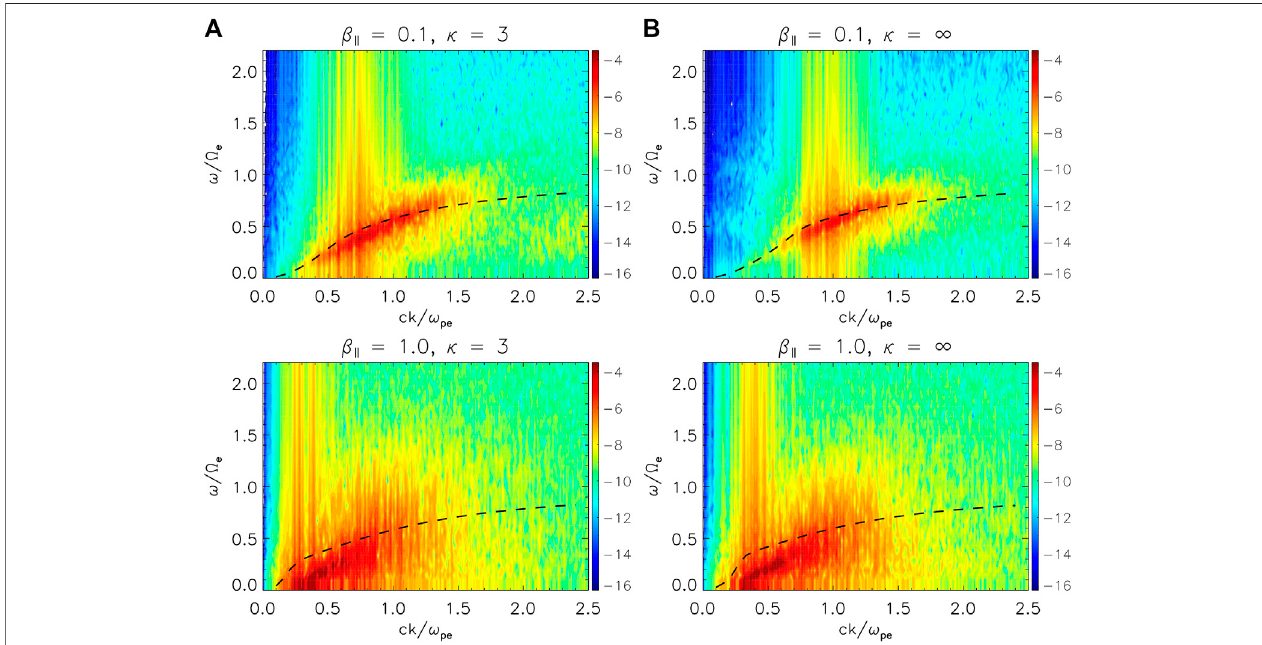
FIGURE 2 | Whistler fl uctuations computed from PIC simulations for bi-Kappa (A) and for bi-Maxwellian (B) electrons with A e (0) (cid:1) 4.0, β e, (cid:3) (0) (cid:1) 0.1 (top) and β (cid:1) 1.0 (bottom) : peaks of the wave magnetic power (color coded) align to the linear dispersion in the frequency ( ω ) – wave-number ( k ) e, (cid:3) (0)